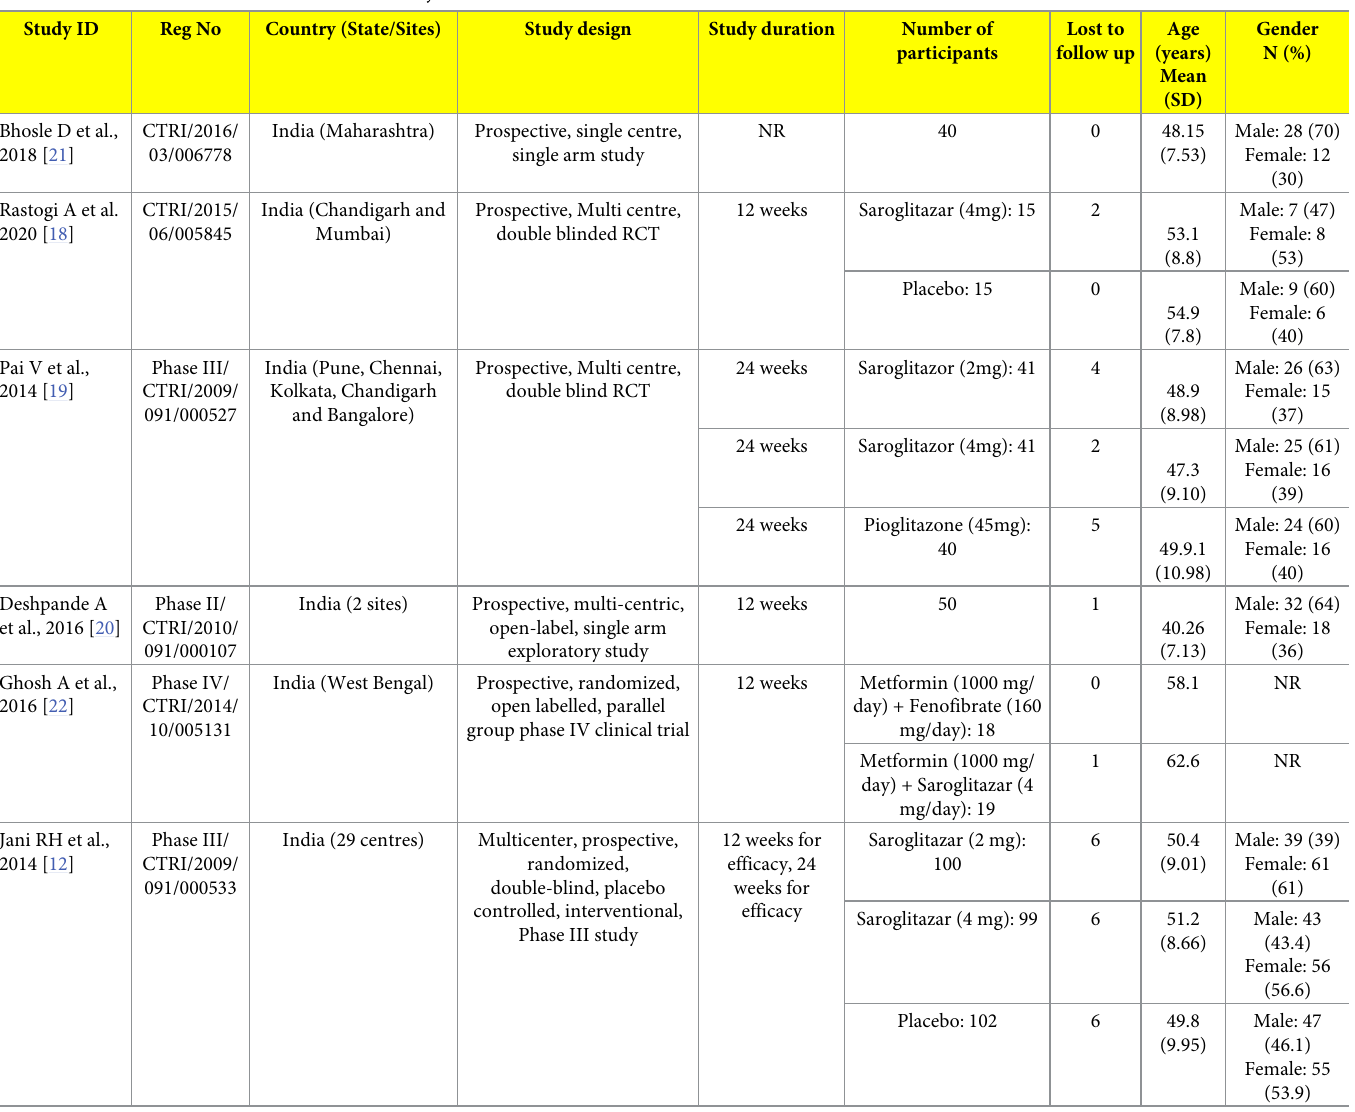
Table 1. Characteristics of included studies and